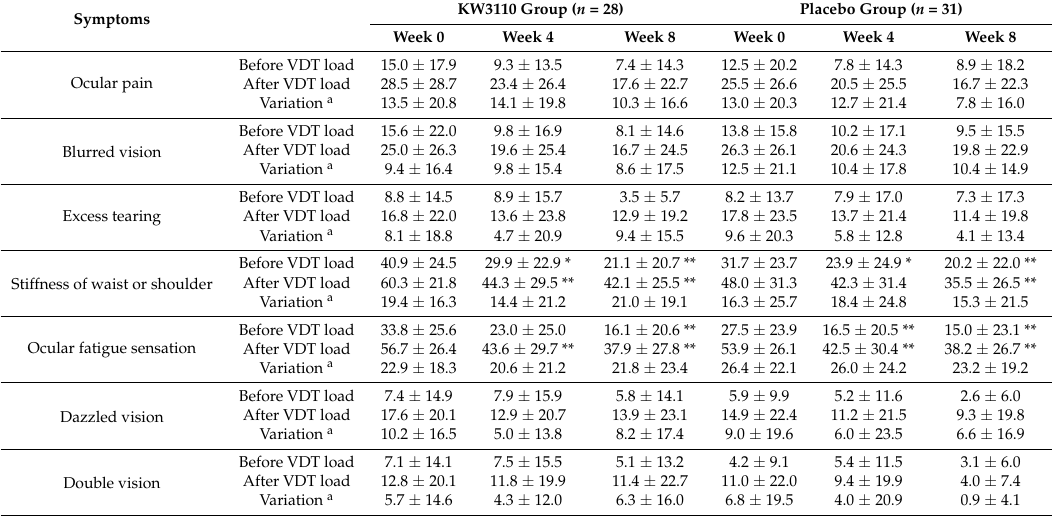
Table 4. The subjective symptoms of eye fatigue and related visual